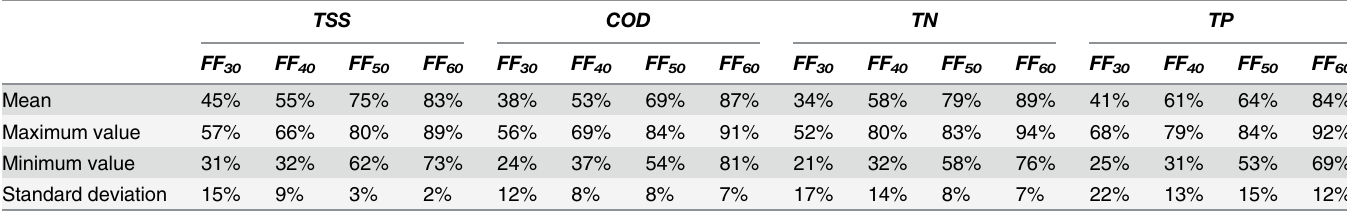
Table 4. Statistical summary of FF 30 , FF 40 , FF 50 and FF 60 for TN , TP , COD and TSS